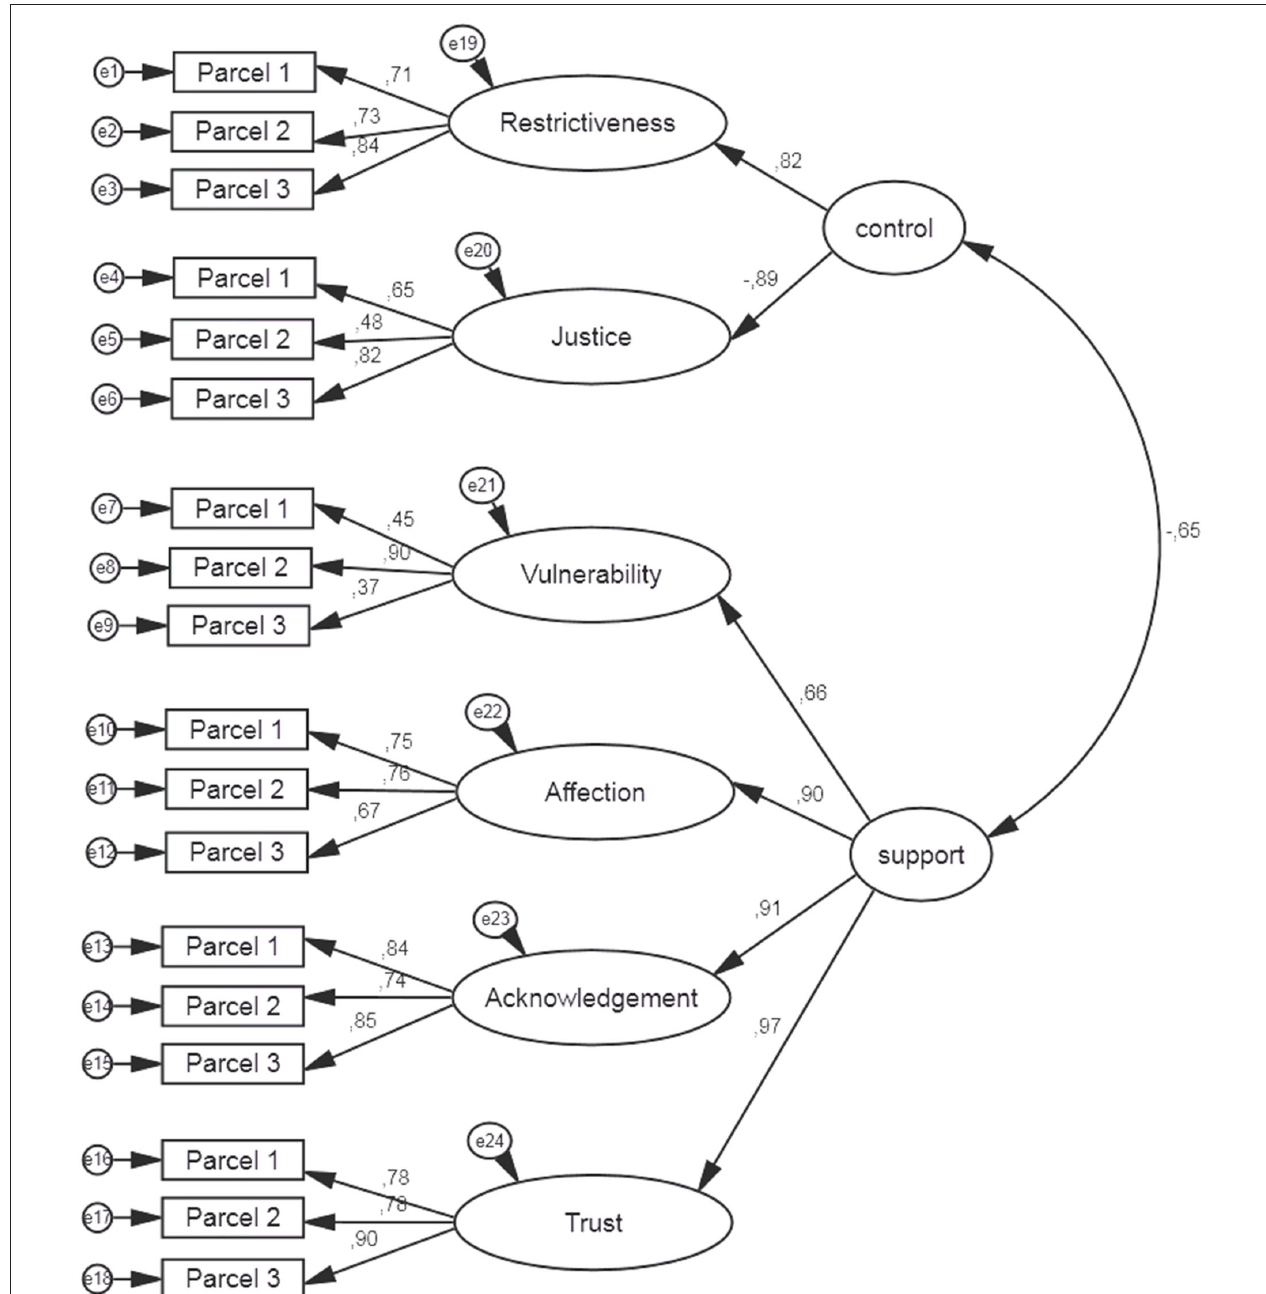
FIGURE 2 | CFA model for the child-mother dyad in the